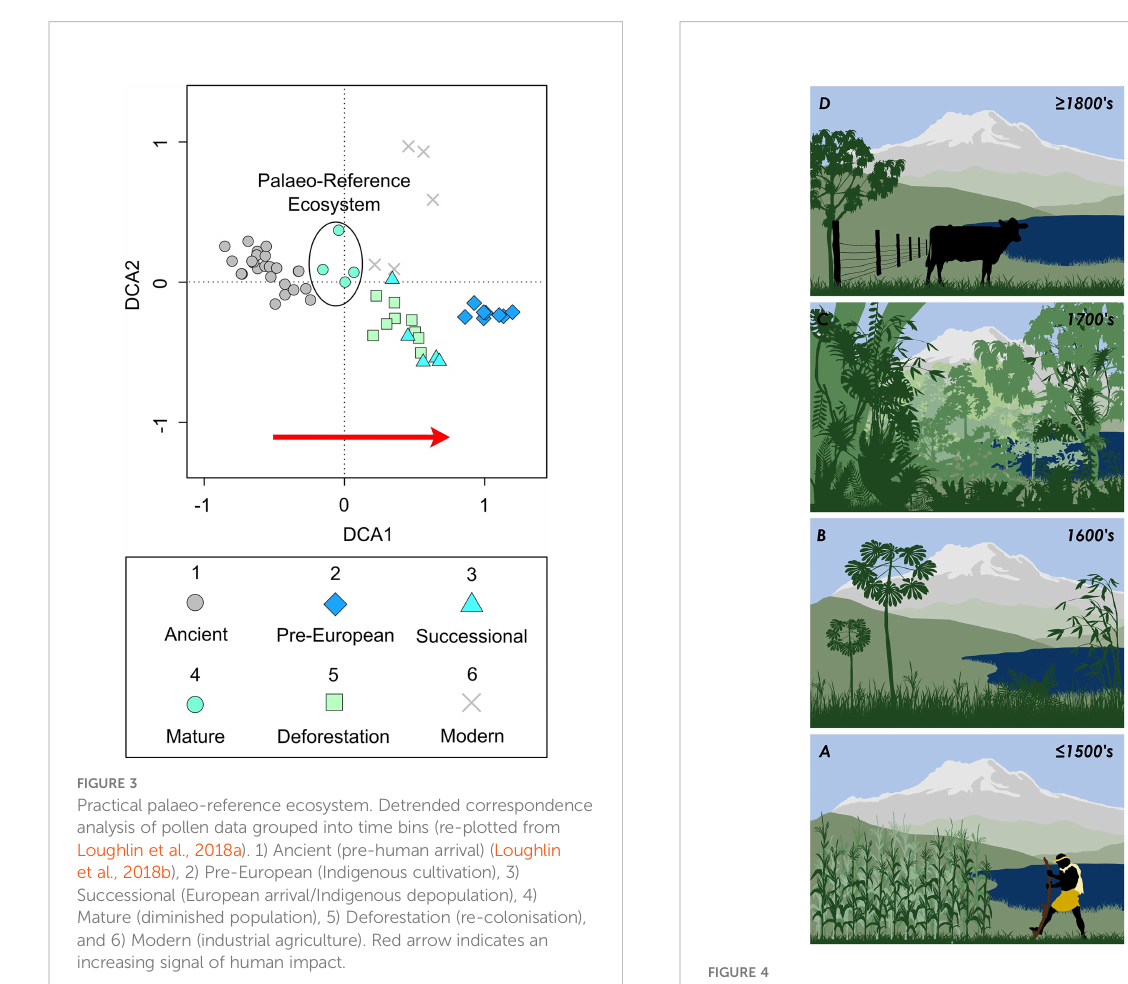
FIGURE 3 Practical palaeo-reference ecosystem. Detrended correspondence analysis of pollen data grouped into time bins (re-plotted from Loughlin et al., 2018a). 1) Ancient (pre-human arrival) (Loughlin et al., 2018b), 2) Pre-European (Indigenous cultivation), 3) Successional (European arrival/Indigenous depopulation), 4) Mature (diminished population), 5) Deforestation (re-colonisation), and 6) Modern (industrial agriculture). Red arrow indicates an increasing signal of human impact.